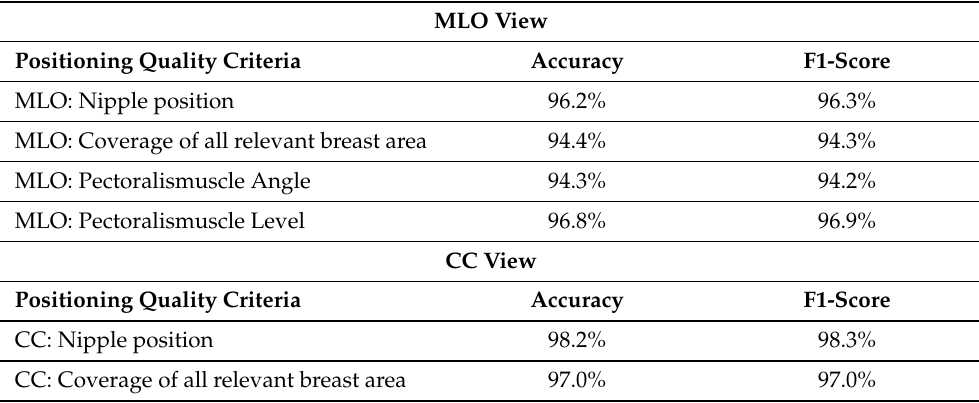
Table 3. Classification results of all implemented models for the assessment of breast positioning quality in both MLO and CC views. MLO